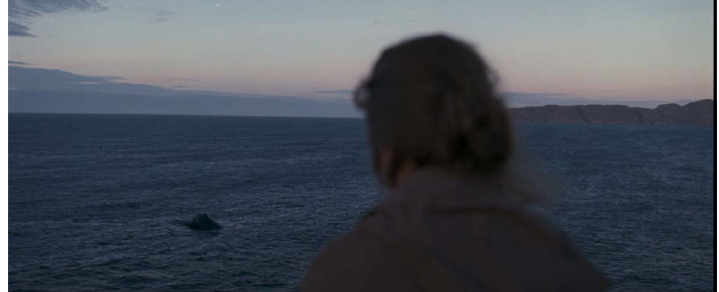
Figure 12. Leviathan (2014).